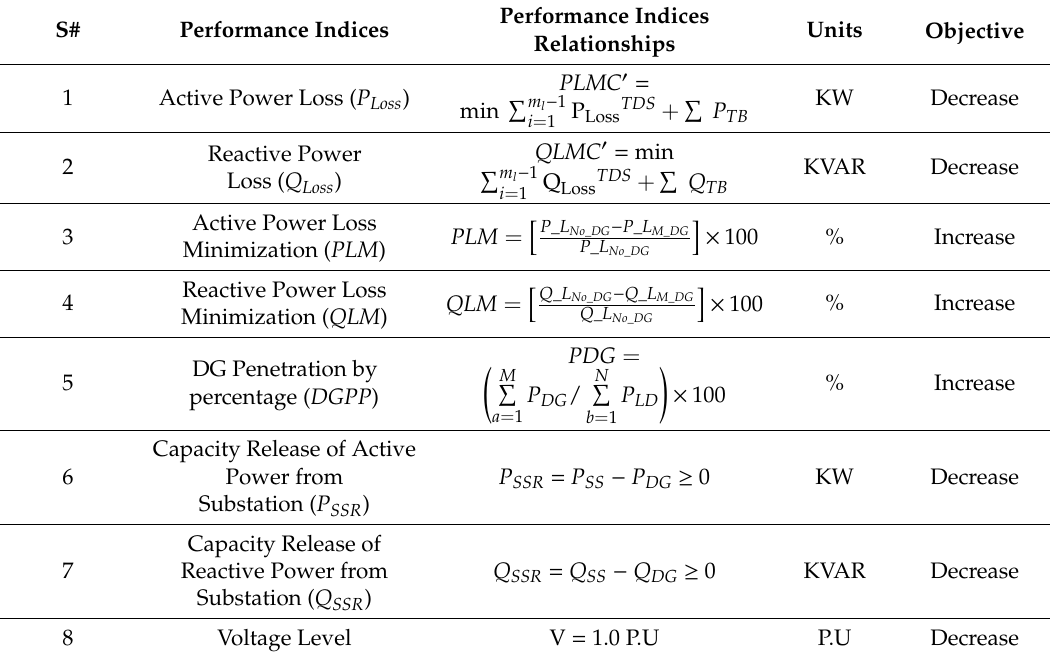
Table 3. Technical indices for performance evaluation (designated as technical performance evaluation (TPE)).